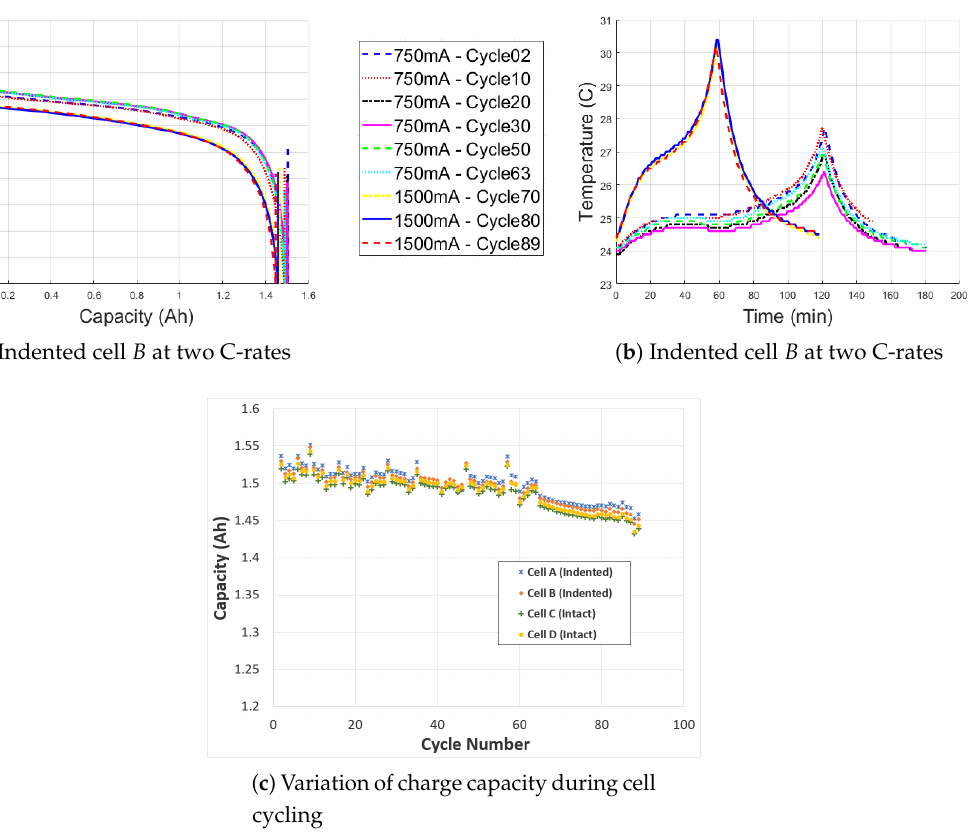
Figure 3. ( a ) Voltage-discharge capacity for various cycles, cell B , ( b ) Temperature change during discharge for various cycles, cell B (Temperature reaches maximum at the end of discharge time, i.e., 120 min for 750 mA and 60 min for 1500 mA discharge rates), ( c ) Variation of charge capacity during cell